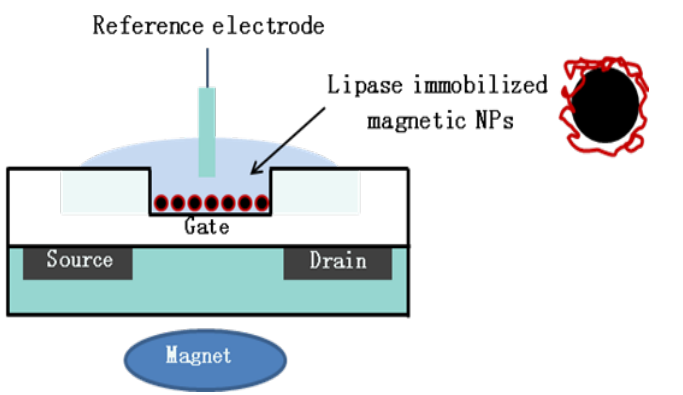
Figure 5. Schematic representation of the ISFET braced to a permanent magnet